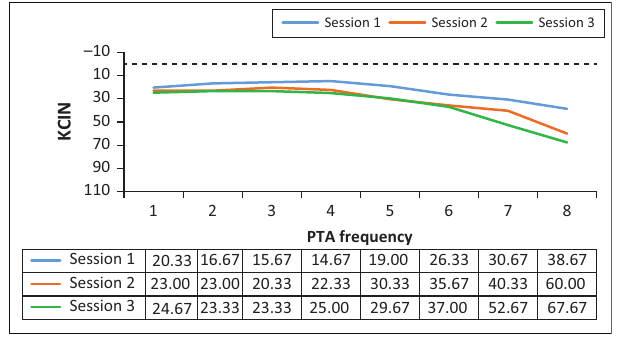
FIGURE 1: Mean left pure-tone audiometry results (in decibel) for the kanamycin treatment, at the three different sessions ( n = 15).